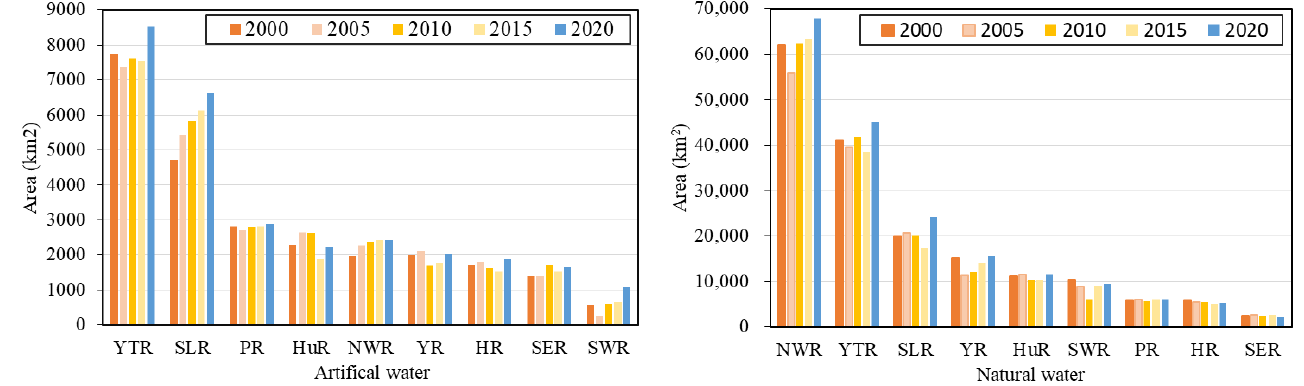
Figure 8. Changes in the areas of artificial and natural water bodies in each basin from 2000 to 2020.